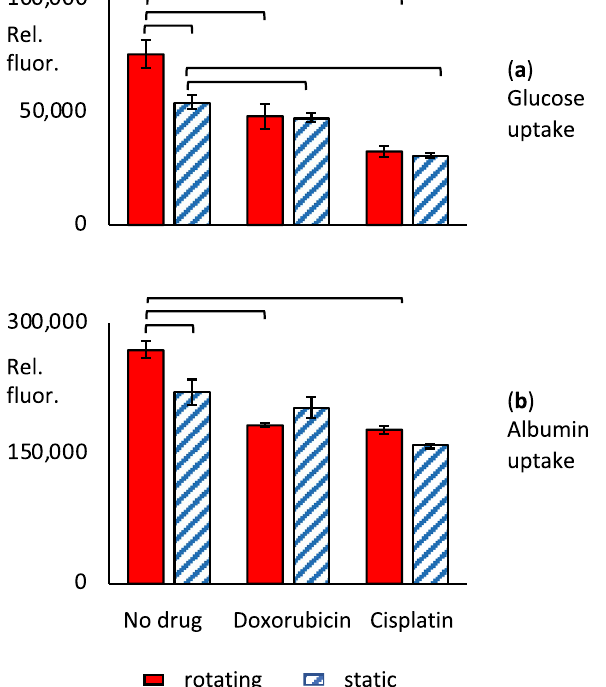
Figure 8. Effect of rotation in cell spinpods on effect of chemotherapeutic agents. RPTEC/hTERT cells on carrier beads were cultured in cell spinpods under rotating conditions ( ) or static conditions ( ) for two days in the presence of 5 µM doxorubicin, 100 µM cisplatin, or no drug control. Panel ( a ) shows the uptake of glucose, measured with the fluorescent substrate 2-NDBG. Panel ( b ) shows the uptake of FITC-albumin. Cells from all samples were trypsinized off the carrier beads before analysis by flow cytometry. Data is presented as mean fluorescence ± SEM of six replicates (except for 5 replicates with static cisplatin), in relative fluorescence units. Brackets mark where differences in the distributions between groups were statistically significant, e.g. p < 0.05, by one-tailed Mann–Whitney U